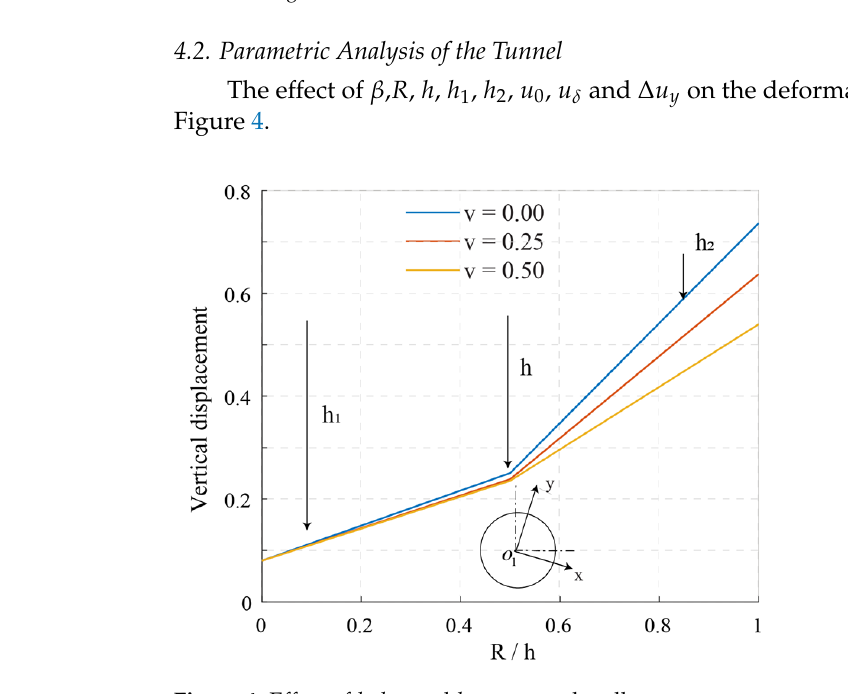
Figure 4. Effect of ℎ , ℎ 1 , and ℎ 2 on tunnel